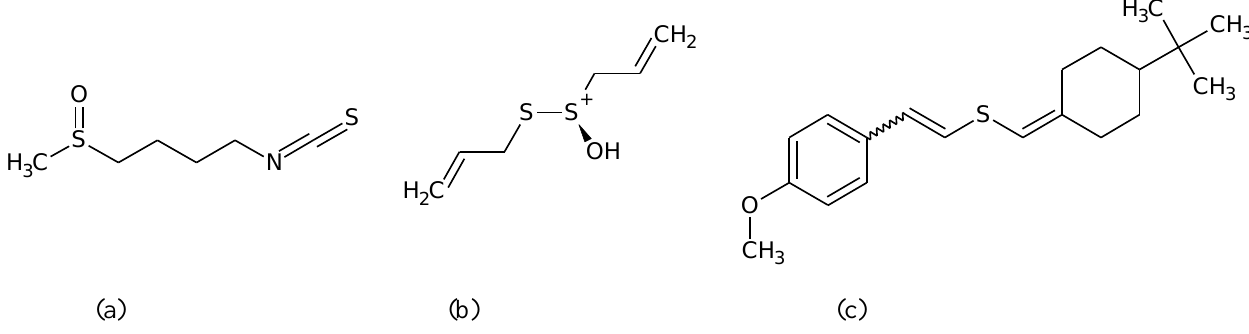
Figure 5. Chemical formula of ( a ) sulforaphane, ( b ) allicin and ( c ) [(4- tert -butylcyclohexylidene)methyl] (4-methoxystyryl)sulfide (BMMS).